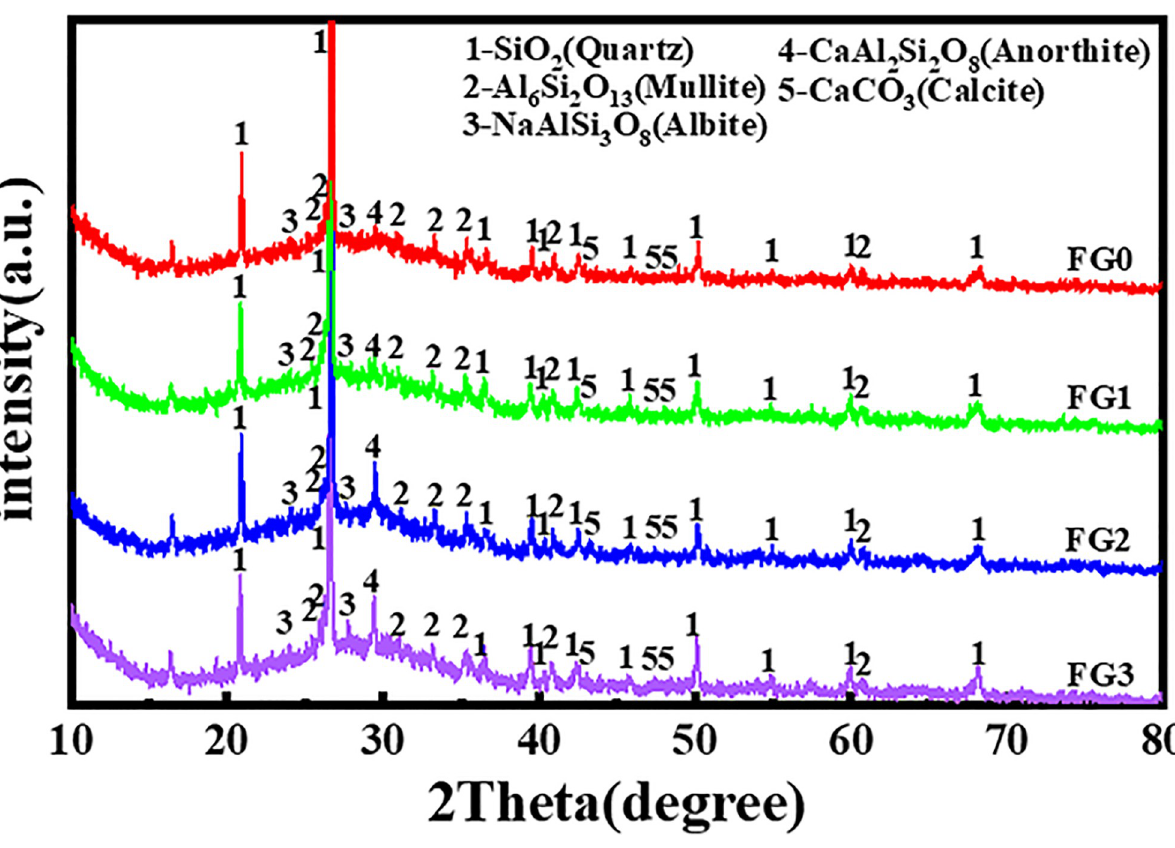
Fig 6. XRD of geopolymer at 28